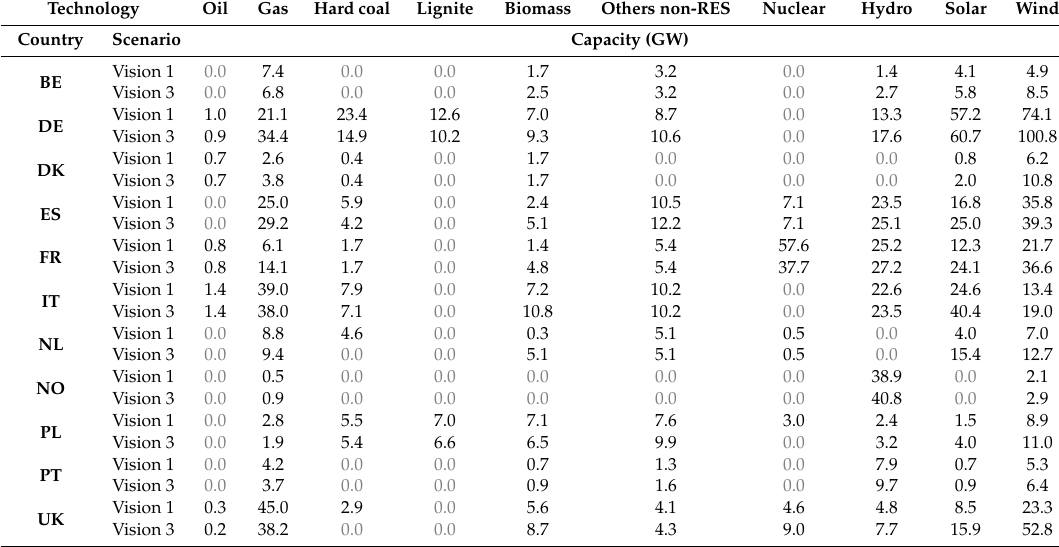
Table 1. Generation share by technology for Vision 1 and Vision 3 in 2030, for selected countries (Data from [59]).